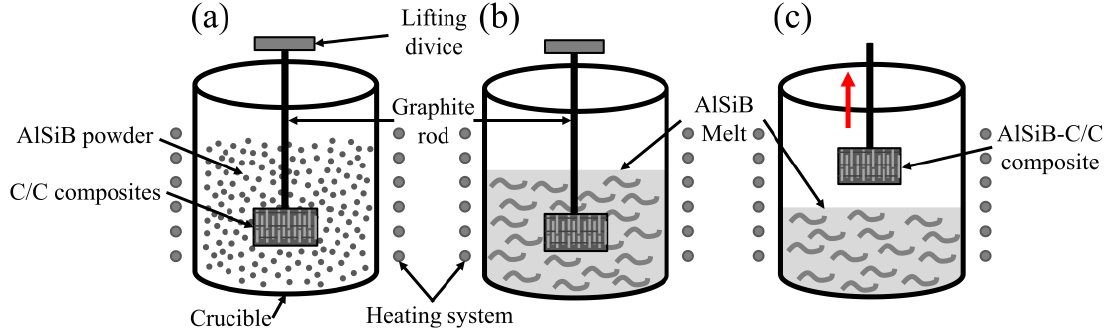
Figure 2. Schematic diagram of the device for infiltrating the AlSiB alloy. ( a ) embedded into powders; ( b ) Reactive melt infiltration; ( c ) Pull out the sample after infiltration.